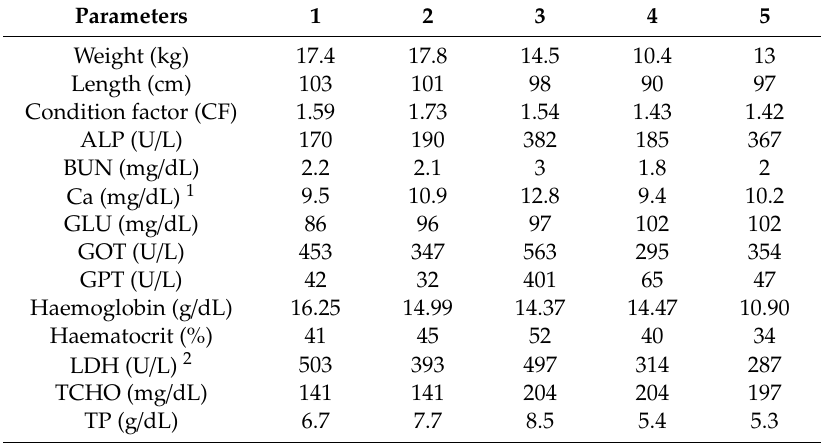
Table 3. Biomass, condition factor (CF) and haematological data of currently analysed Pacific bluefin tuna ( Thunnus orientalis ) 1 to 5.